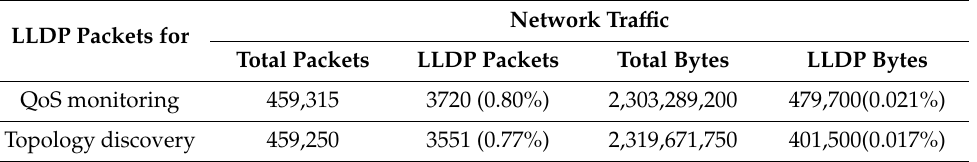
Table 2. (QoS monitoring vs. topology discovery) over LLDP. LLDP Packets for